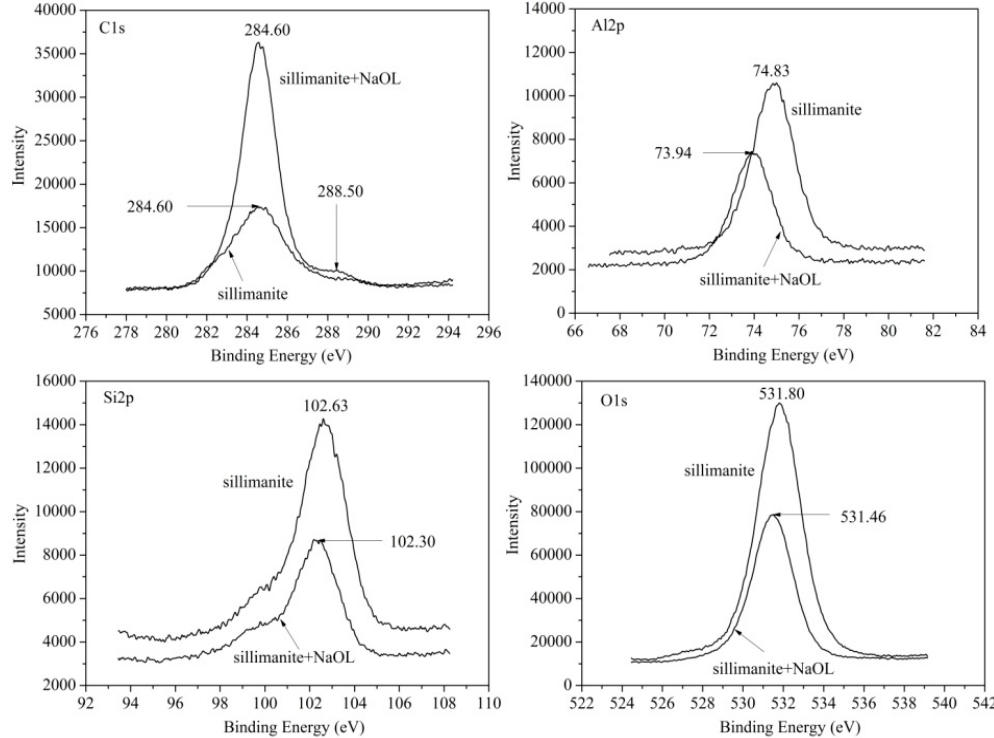
Figure 10. XPS high-resolution spectra of C1s, Al2p, Si2p and O1s on sillimanite in the absence and presence of sodium oleate (NaOL).